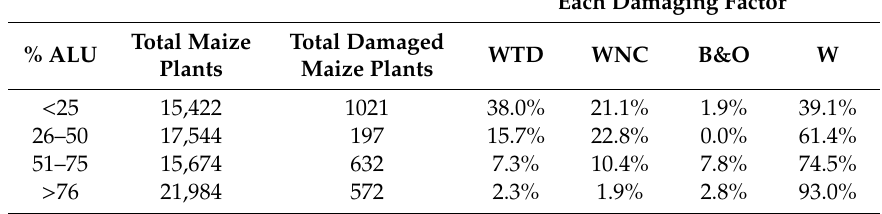
Table 2. Total maize cobs, total damaged maize cobs and percentage of damaged maize cobs by different factor (WTD = white-tailed deer; WNC = white-nosed coati; B&O= birds and others; W = wind), on all maize fields within each of the four ranges of percentage of agricultural land use (%ALU) within a 100 m buffer around each field.